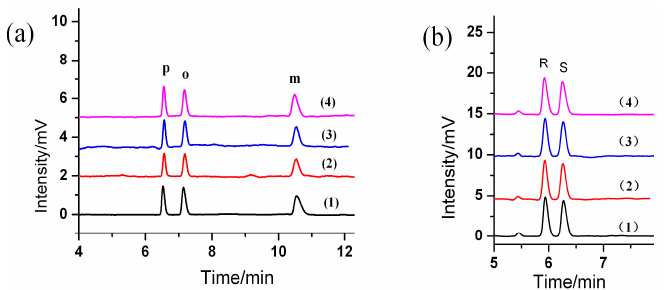
Figure 4. Reproducible chromatograms on the pentyl cage-coated capillary column for the separation of ( a ) o -, m -, and p- nitrochlorobenzene at 115 °C under a N 2 flow rate of 14.9 cm ∙ s − 1 ( b ) styrene oxide at 110 °C under a N 2 linear velocity of 10.8 cm ∙ s − 1 (1) Chromatograms obtained before the column were repeatedly used; (2), (3) and (4) chromatograms obtained after the columns have been subjected to 100, 300, and more than 500 injections, respectively.